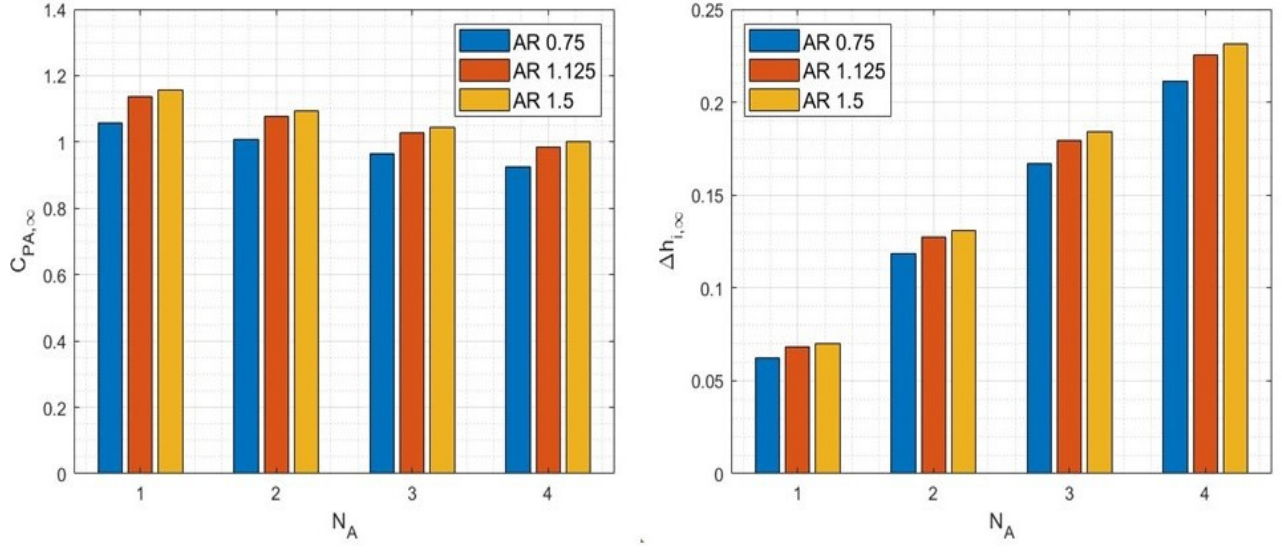
Figure 12. ( Left ) Array power coefficient C PA, ∞ vs. number of arrays N A . ( right ) Free surface variation Δ h i, ∞ vs. number of arrays N A . Different colors indicate the various simulations (blue markers indicate 2-turbine arrays with AR = 0.75, red markers indicate 3-turbine arrays with AR = 1.125, and yellow markers indicate 4-turbine arrays with AR = 1.5).